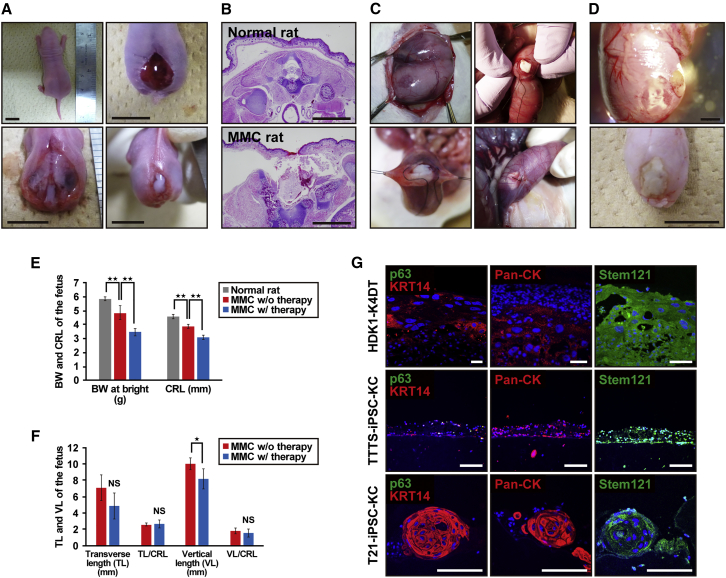
The Rat Model of Myelomeningocele with Application of Artificial Skin(A) Gross pathology images of the MMC lesion site at birth in a normal rat (upper left panel) and MMC rat (upper right and lower panels). MMC rat shows defects in skin (upper right) and spine (lower left), and exposure of spinal cord (lower right). Scale bars, 1 cm.(B) Cross-sectional images of spinal cord at lumbar levels of a normal rat and MMC rat. Scale bars, 2 mm.(C) Gross view of the intrauterine transplantation of artificial skin. Representative images of major steps of the MMC repair process in the fetal rat model. An MMC defect site was identified through the uterus (upper left panel). A small incision of the uterus was made just above the defect site, following which artificial skin was transplanted (upper right panel). Finally, the uterine wall was closed over the defect (lower panels).(D) Gross views of neonatal rat with myelomeningocele (MMC) at birth (E22). Representative photograph in incomplete closure (upper panel) and complete closure (lower panel) after artificial skin application at day 20. Scale bars, 2 mm (upper panel) and 1 cm (lower panel).(E) Birth weight (BW) and craniocaudal length (CRL) of normal neonatal and neonatal MMC rats with or without fetal therapy. MMC rats in the fetal therapy group (n = 3) were born with smaller BW and CRL compared with normal rats (n = 14) or nontreated MMC rats (n = 6). ∗∗p < 0.01.(F) Comparison of MMC defect size between neonatal MMC rats with fetal treatment (n = 3) and rats without therapy (n = 6). There were no significant differences in the MMC size by fetal therapy when adjusted for the CRL. TL, transverse length; VL, vertical length. ∗p < 0.05; NS, not significant.(G) Expression profile of epidermal markers and short-term in vivo effect on regeneration of rat skin defect in artificial skin. Transverse section through the myelomeningocele defect 2 days after transplantation of artificial skin with iPSC-KC epidermis. The expressions of epidermal markers, i.e., KRT14, p63, pan-cytokeratin (Pan-CK), and stem121, were analyzed in artificial skin with HDK1-K4DT, TTTS-iPSC-KCs, or T21-iPSC-KCs. Scale bars, 100 μm.